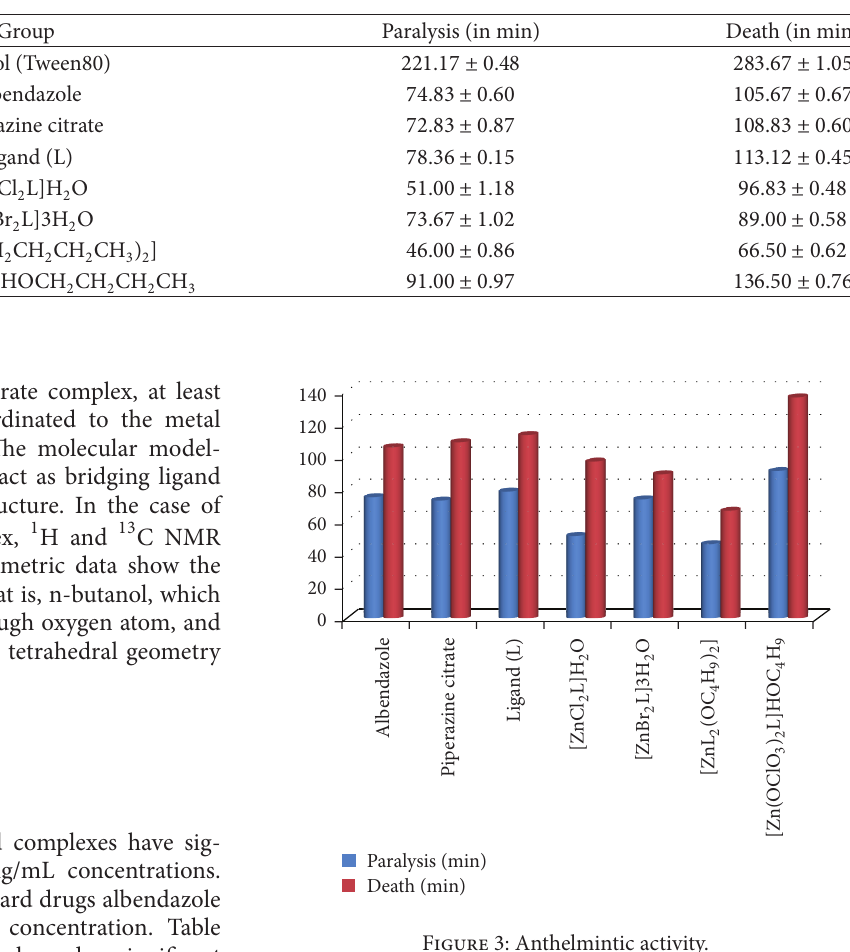
T 6: Showing anthelmintic activity of synthesized complex compounds with standard.